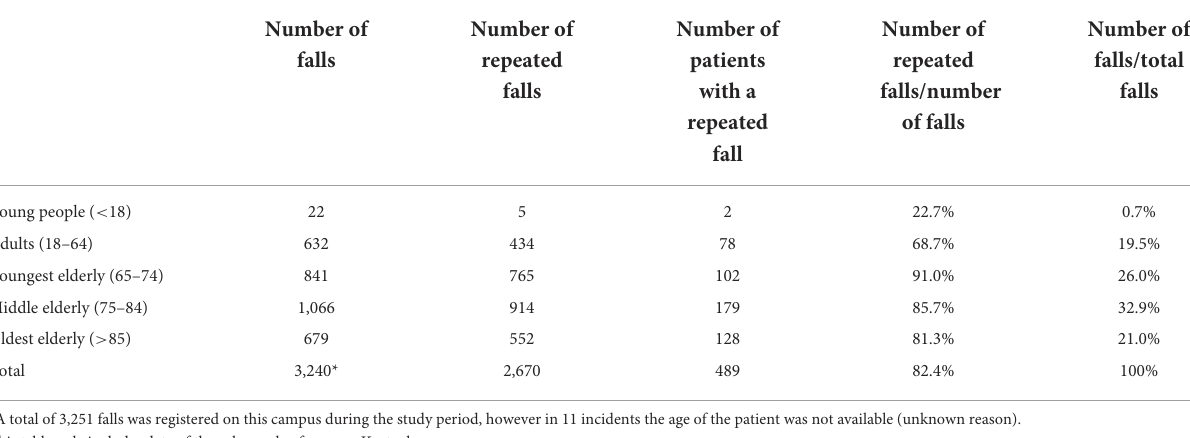
TABLE 4 Data on the age distribution in the ‘repeated falls’ group (campus Kortenberg).